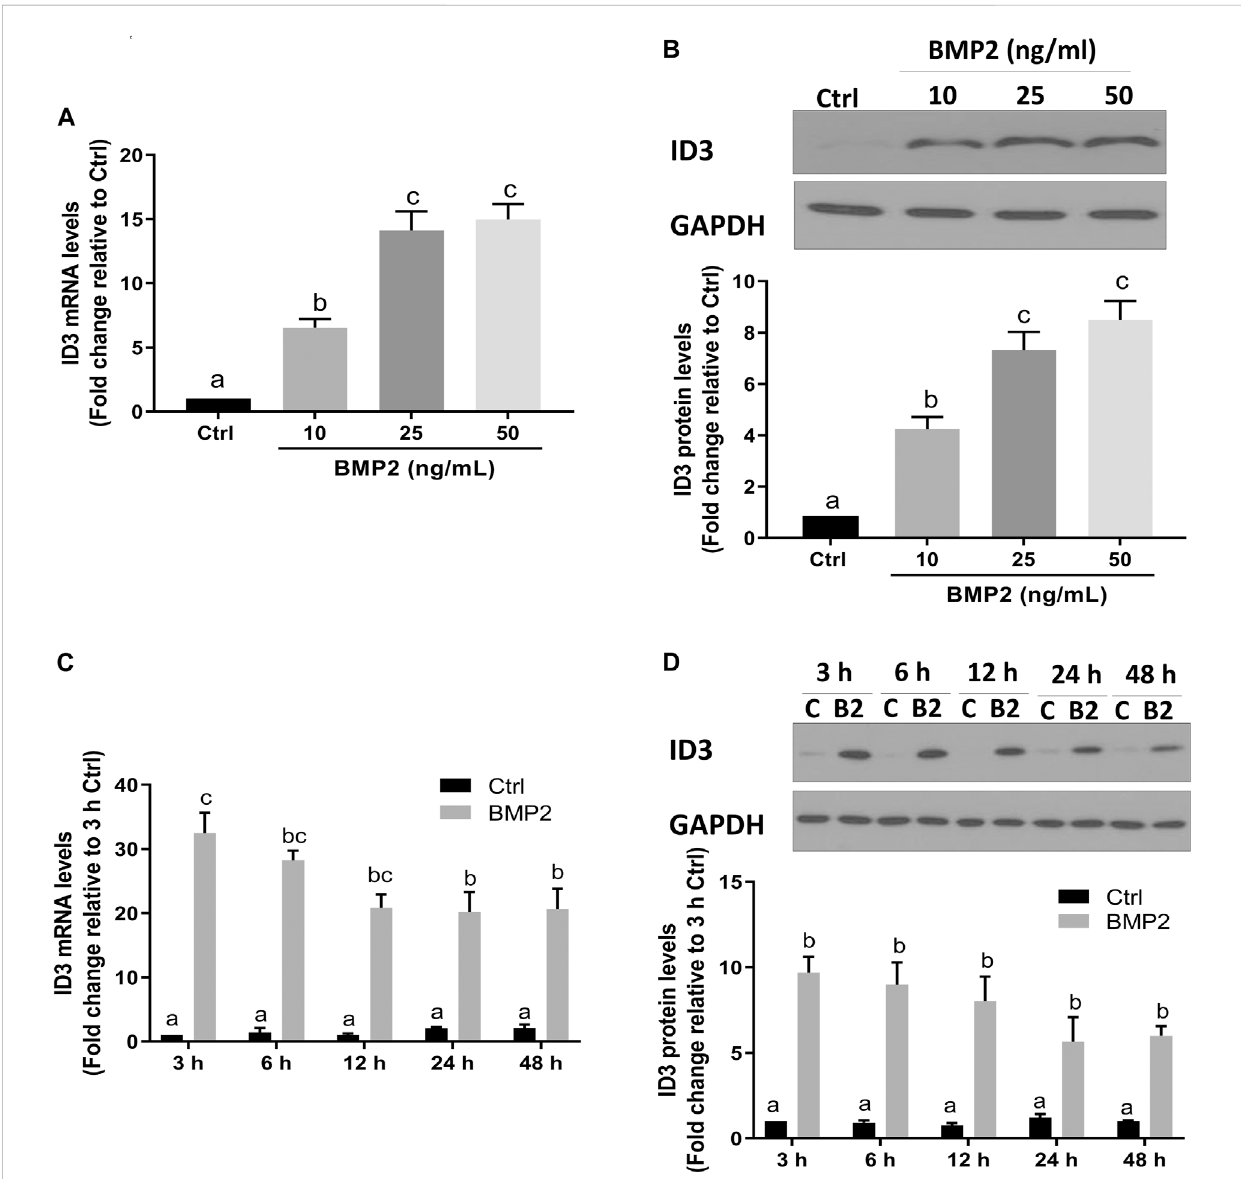
FIGURE 4 BMP2upregulatestheexpressionofID3inHESCs.(AandB)HESCsweretreatedwithdifferentconcentrations(0,10,25,50 ng/mL)ofBMP2for24 h, and the mRNA (A) and protein (B) levels of ID3 were examined using RT-qPCR and Western blot analysis, respectively. (C,D) HESCs were treated with 25 ng/mL of BMP2 for 3, 6, 12, 24 or 48 h, and the mRNA (C) and protein (D) levels of ID3 were examined using RT-qPCR and Western blot analysis, respectively. The results are expressed as the mean ± S.E.M. of at least three independent experiments. Different letters indicate a signi fi cant difference ( p <